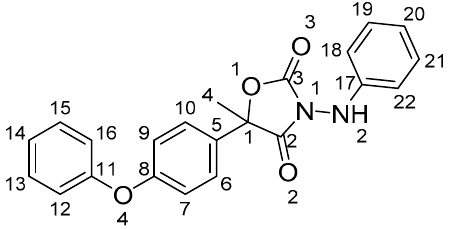
Figure 1. Molecular structure of famoxadone.